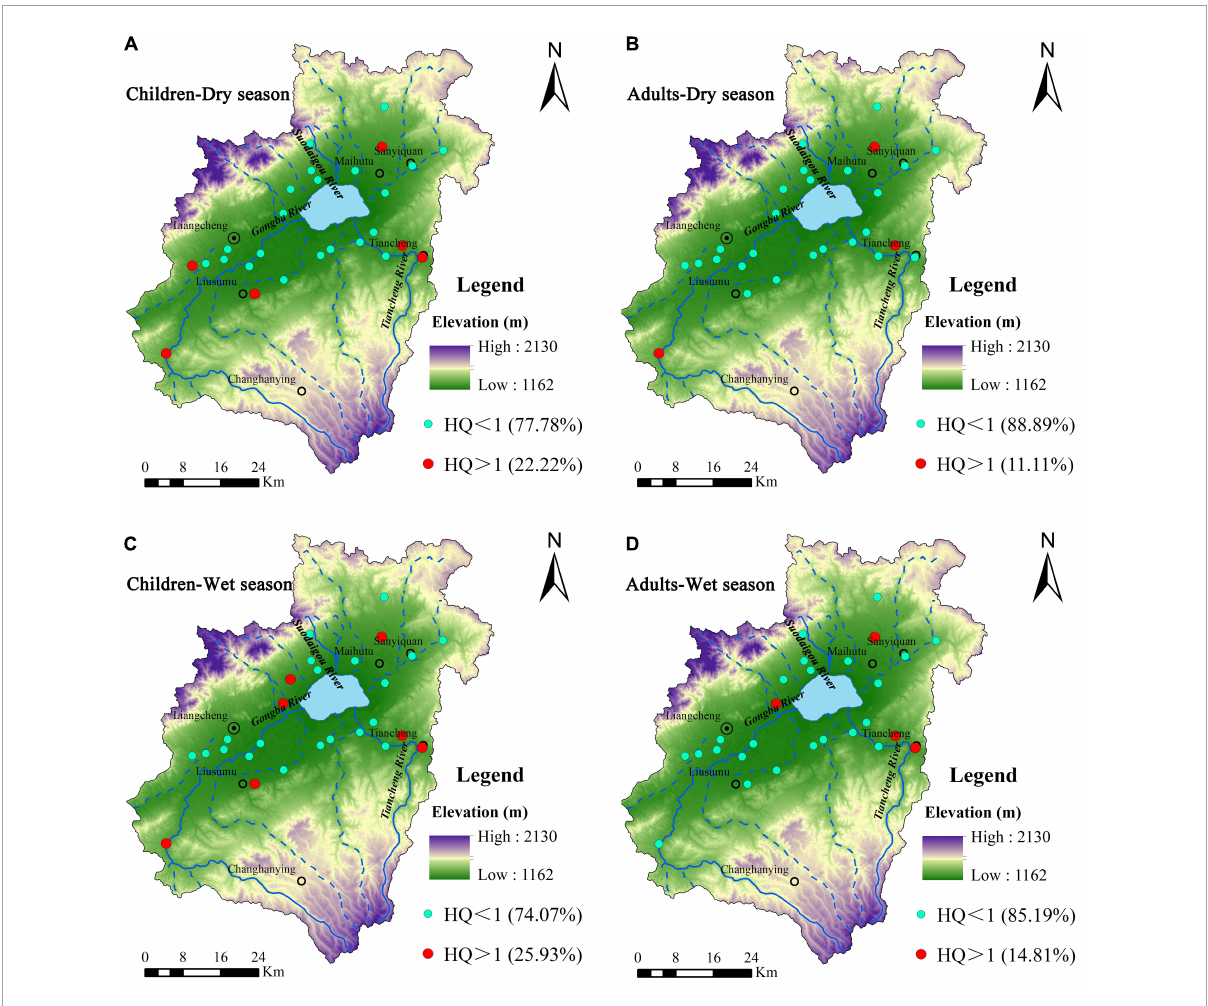
FIGURE6 Spatial distribution of the results of health risk assessment of groundwater NO 3 − in the Daihai Lake Basin for children during the dry season (A) , adults during the dry season (B) , children during the wet season (C) , and adults during the wet season (D)